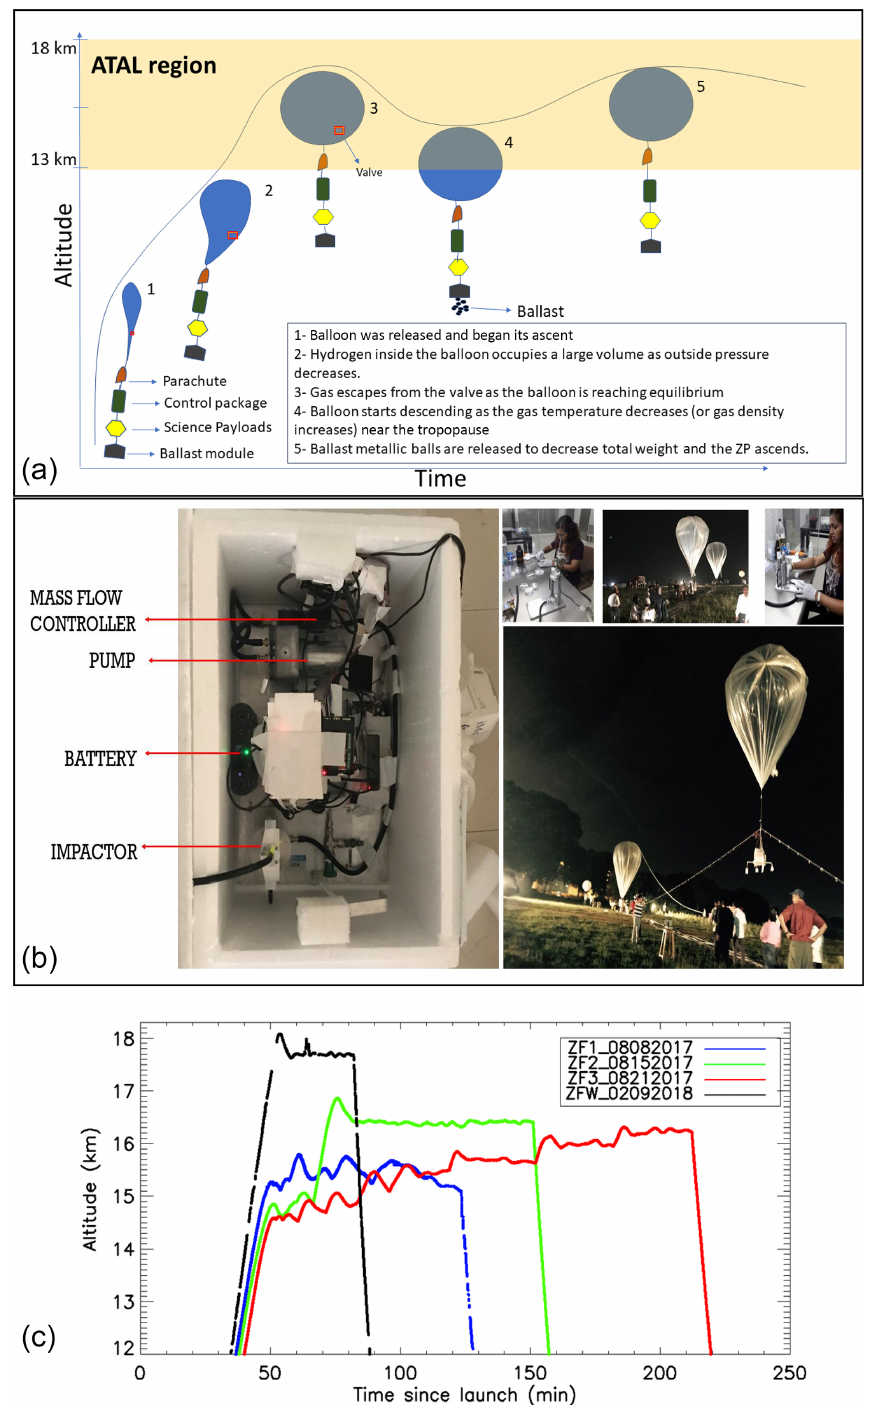
Figure 1. (a) Schematic diagram of the zero-pressure flight (ZP) concept. (b) Picture of the science payload, impactor preparation, and balloon flight launch. (c) Time–height curves of the GPS altitudes of the three zero-pressure flights during summer 2017, in comparison with that of winter 2018, launched from TIFR-BF, Hyderabad,